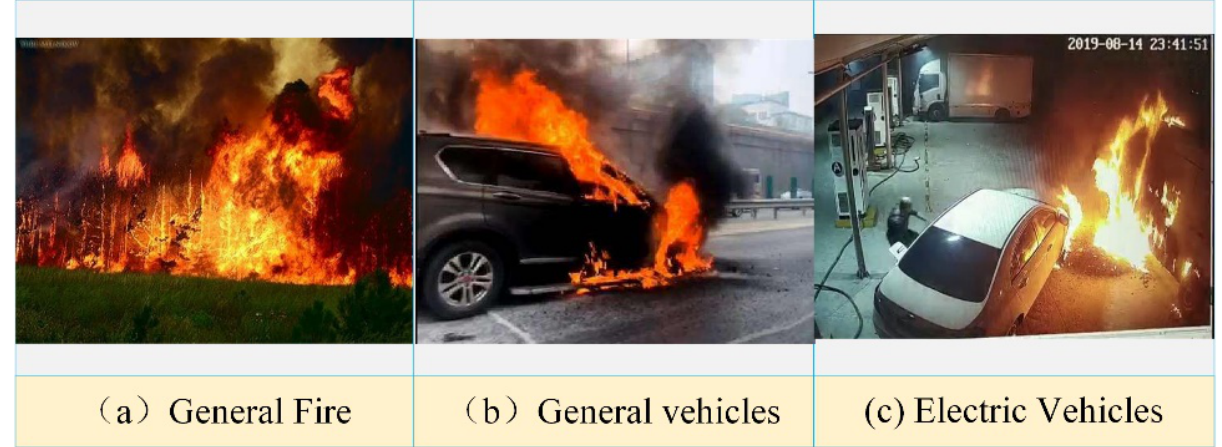
Figure 1. Dataset